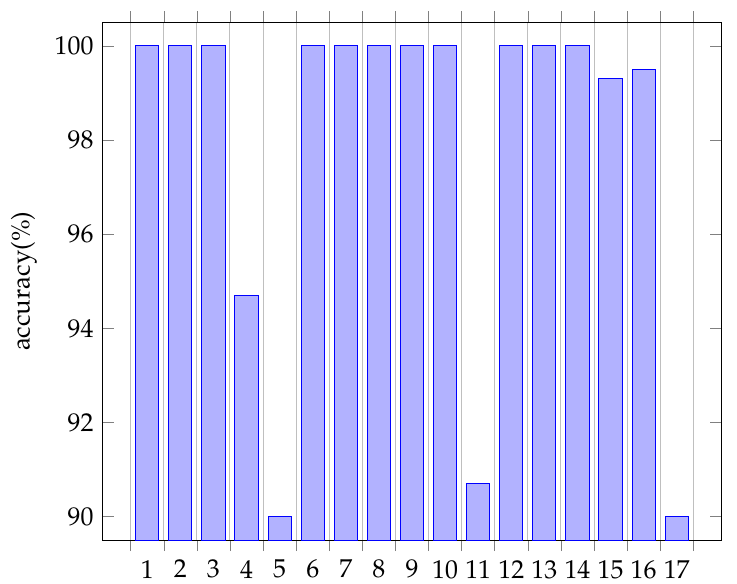
Figure 10. Character recognition rates for screenshot table images. Figure 12. Character recognition rates for screenshotted table images.